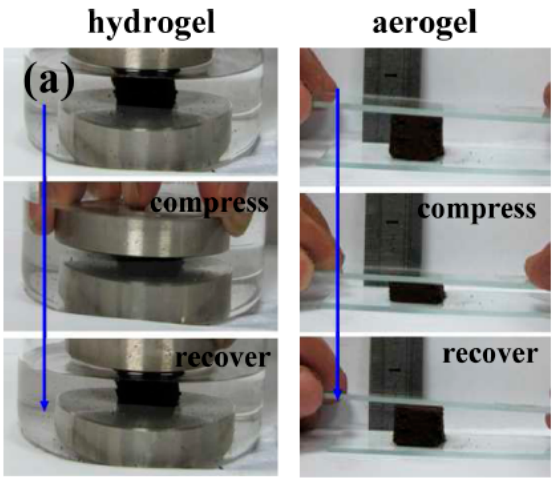
Figure 1. Digital photographs illustrating the compressive properties of hydrogels and aerogels.